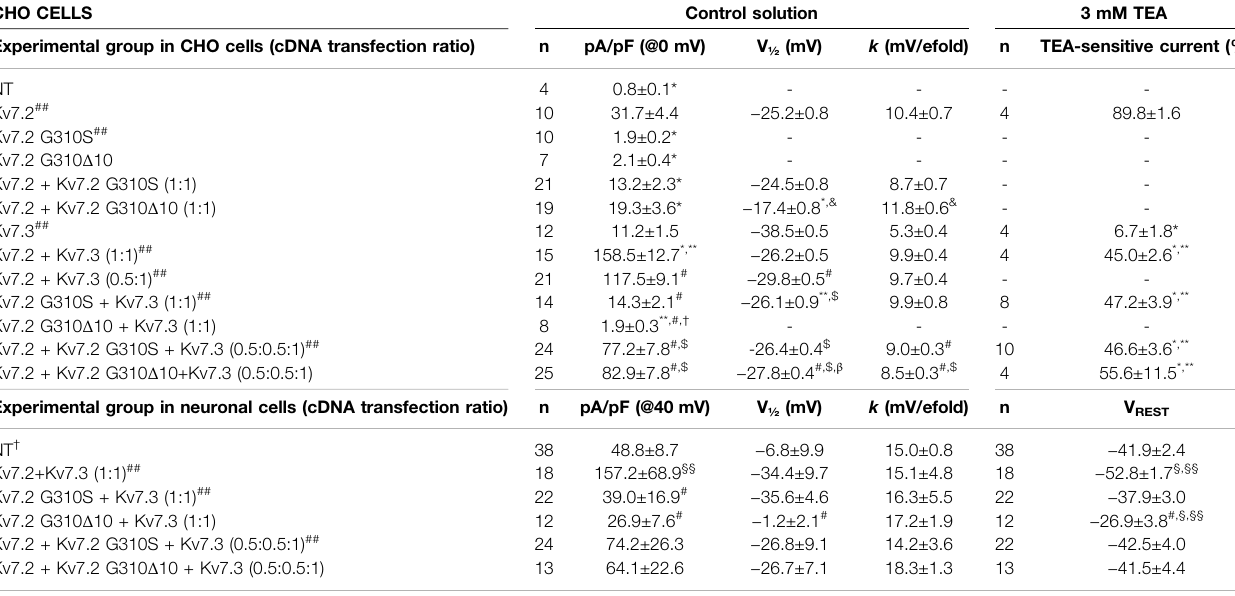
TABLE 1 | Functional properties of currents of wild-type or mutant Kv7.2 subunits when expressed in CHO cells or cortical neurons. CHO CELLS Control